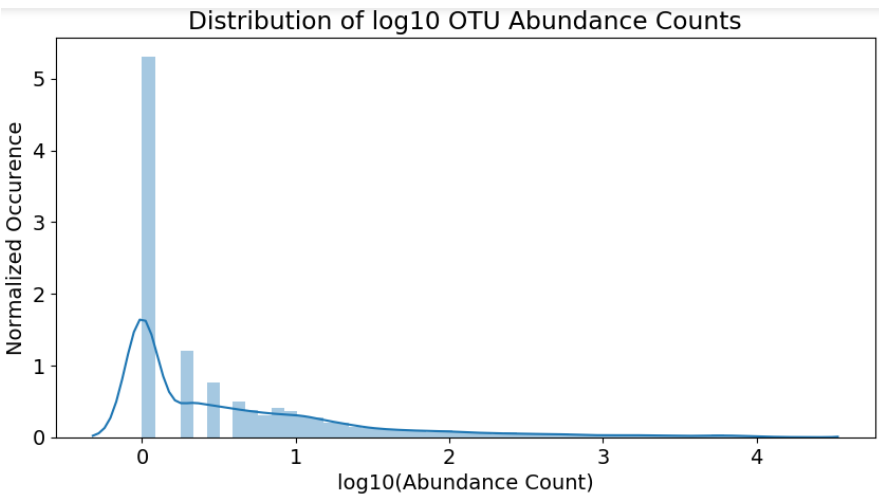
Figure 5. Distribution of OTU abundance counts, after log 10